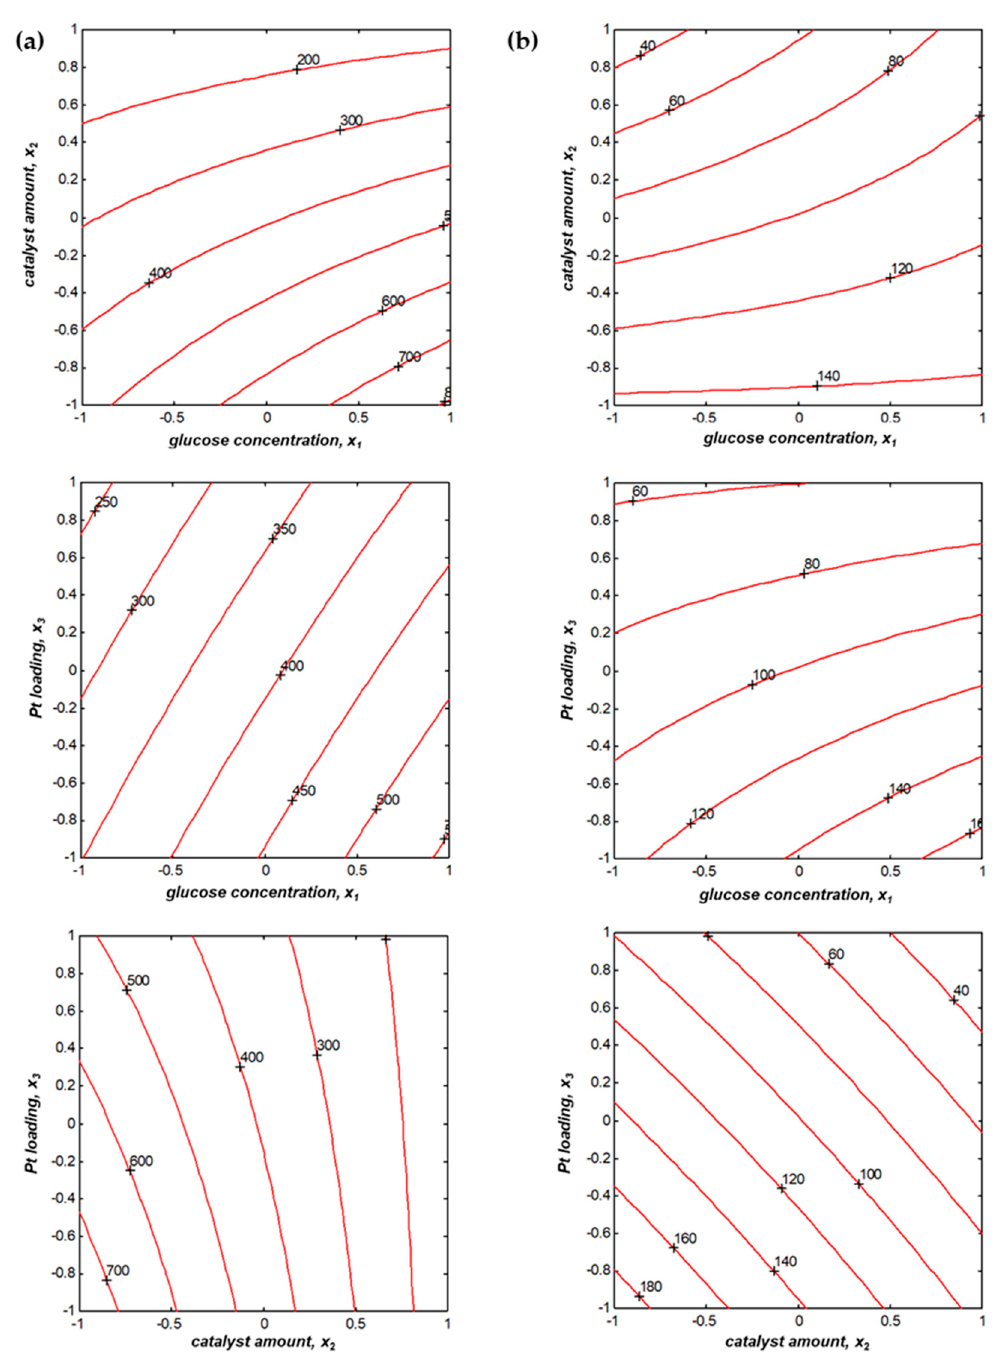
Figure 2. Response surfaces obtained by Matlab  elaboration for ( a ) DMASnBr 3 /g-C 3 N 4 and ( b ) ( b ) PEA 2 SnBr 4 / g-C 3 N 4 (for level codes − 1 + 1 see Table 1); the number close to each curve represents PEA 2 SnBr 4 /g-C 3 N 4 (for level codes − 1 +1 see Table 1); the number close to each curve represents the the HER.